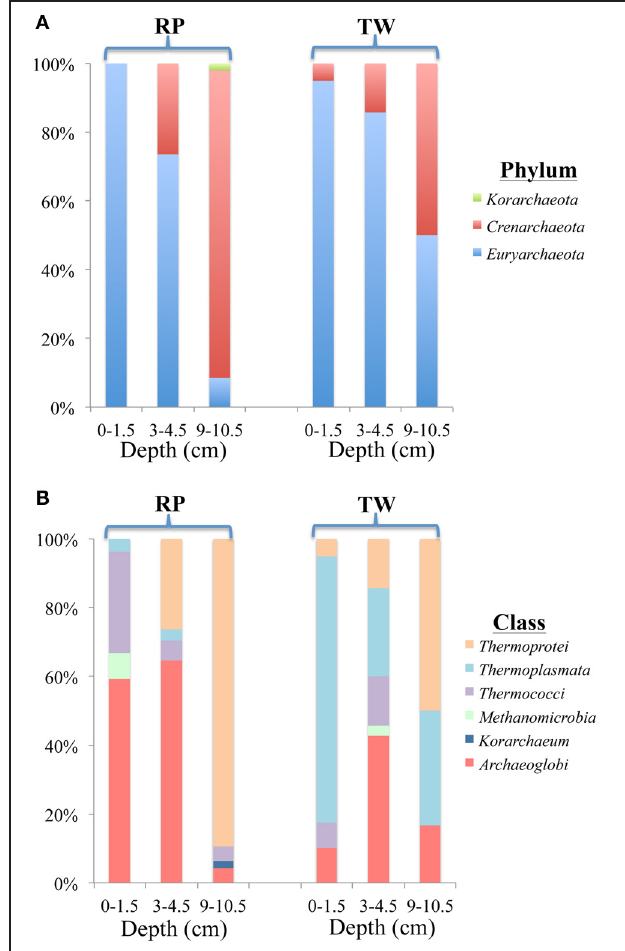
FIGURE 6 | Diversity and distribution of clones within archaeal phylum (A) and class (B) clone libraries for three depths of RP and TW sediment layers investigated in this study. Each color represents the percentages of each taxon in the total respective clone library, as determined by screening of full length 16S rRNA gene sequences. Depths are 0–1.5, 3–4.5, and 9–10.5cm, and indicated at the bottom of site